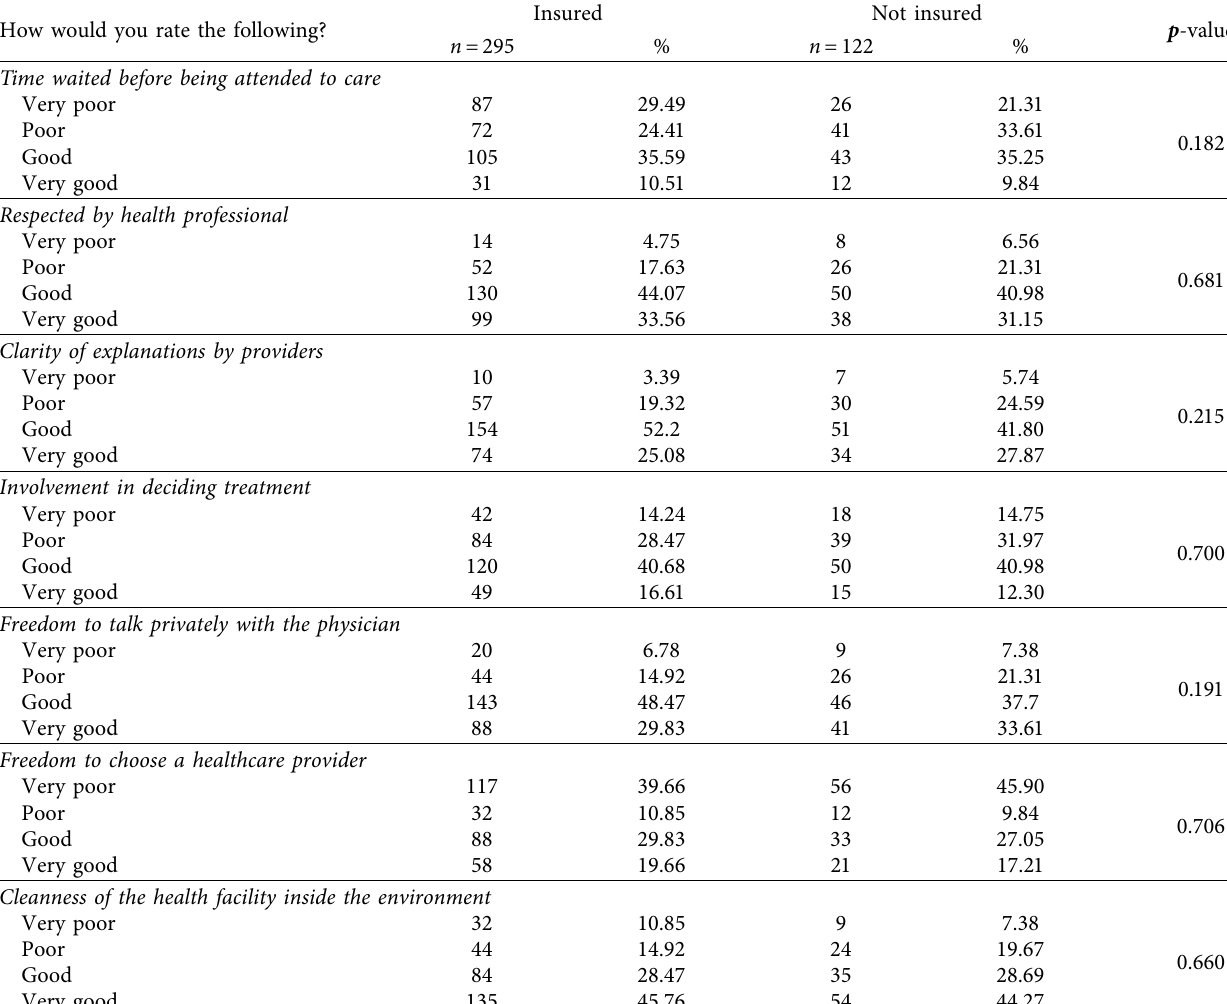
Table 3: Health system responsiveness among outpatients by health insurance status in primary health facilities, Ethiopia, 2021. How would you rate the